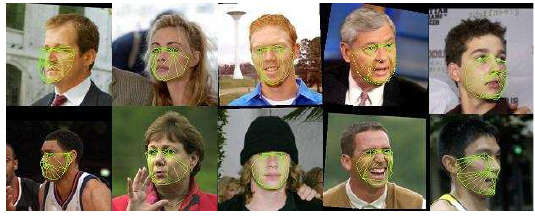
Figure 3. From left to right: left, middle-left, frontal, middle-right and right mesh